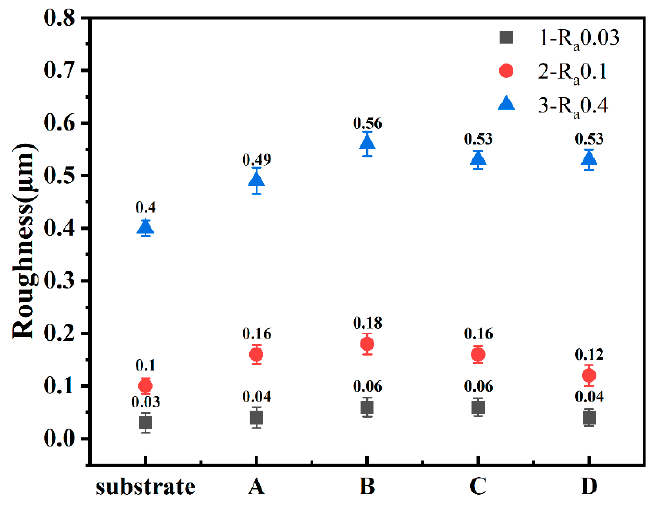
Figure 2. Roughness of diamond films.